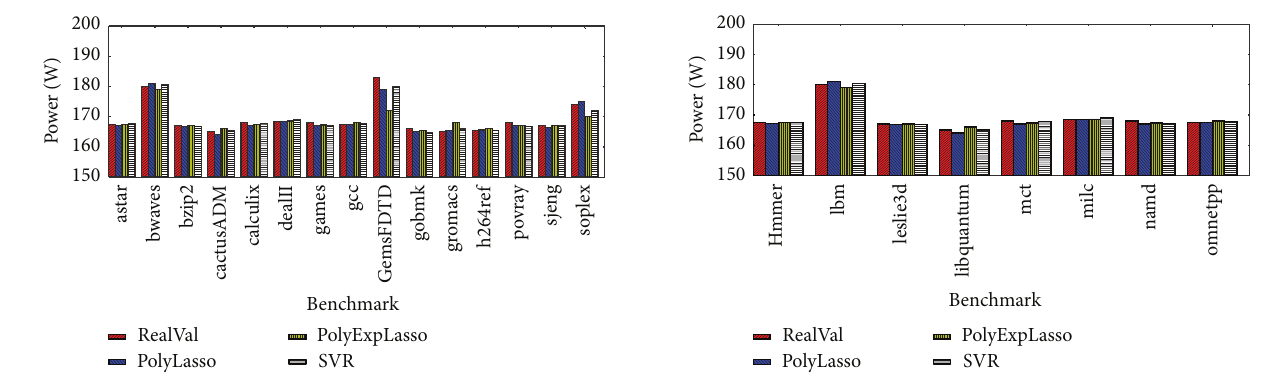
Figure 4: Result comparison on test data.